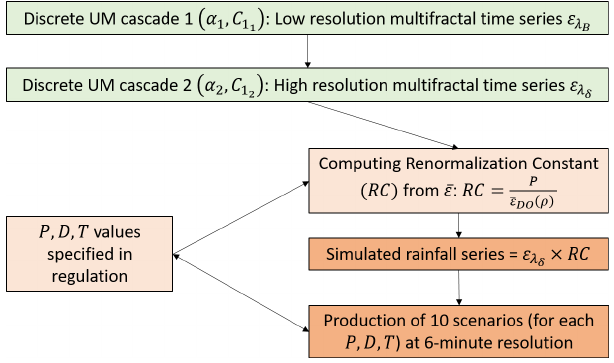
Figure 5. Schematic illustration of the simulation procedure used in this study to generate temporal reference rainfall